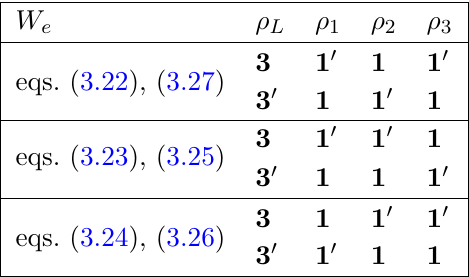
Table 1. The possible assignments of irreps for the L , E c minimal set-up. For each form of W e , the upper and lower lines lead to the same results for the matrix (cid:21)